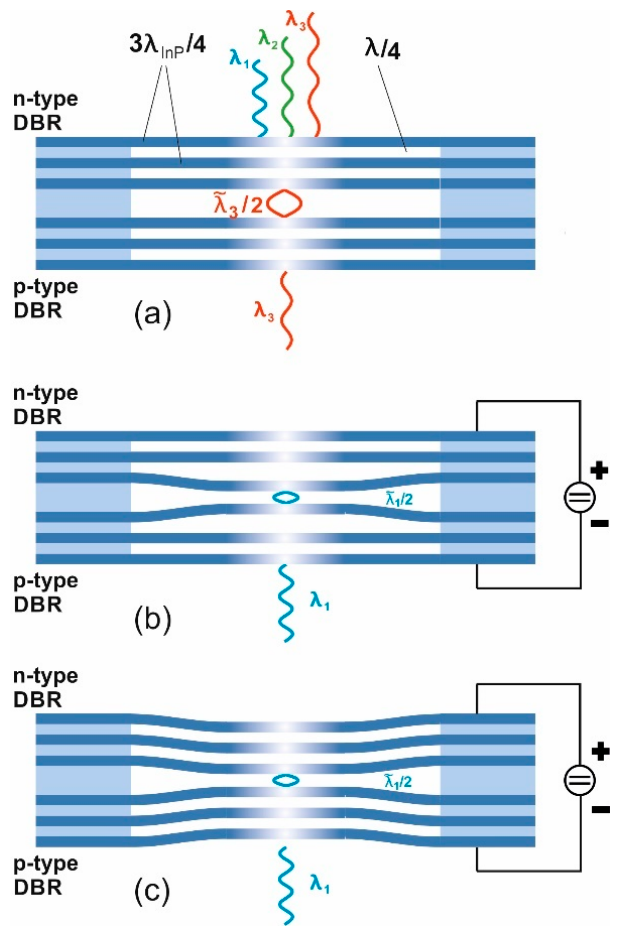
Figure 17. Schematic of MEMS tunable FP filters including multiple air-gaps and membranes and suspensions made of InP. The supporting posts are built of the complete InP/InGaAs multilayer stack, as grown by epitaxy. ( a ) Unactuated state; ( b ) Actuated state where only the two central membranes of the DBRs are actuated; ( c ) Actuation of all membranes (i.e., actuating the whole two